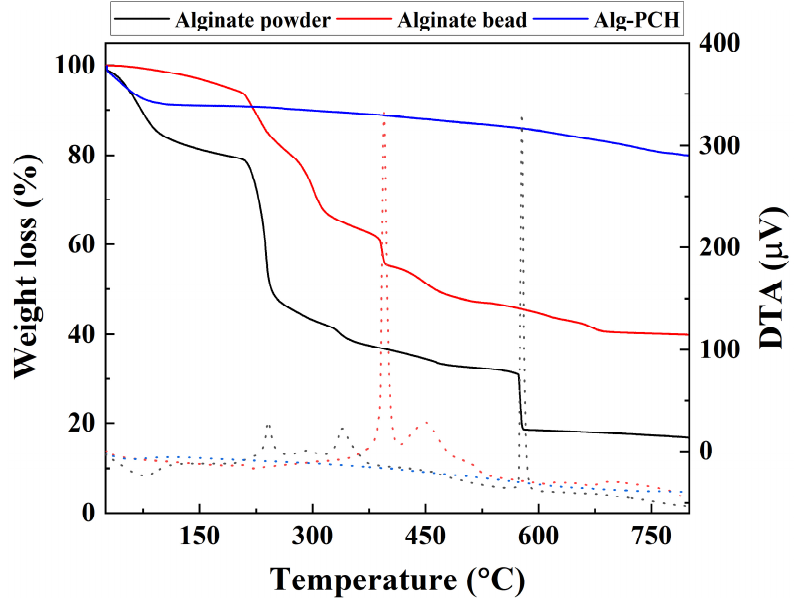
Figure 4. Thermal gravimetric analysis (TGA; solid line) and differential thermal analysis (DTA; dashed line) results of alginate powder, powdered alginate bead, and dashed line) results of alginate powder, powdered alginate bead, and Alg-PCH.